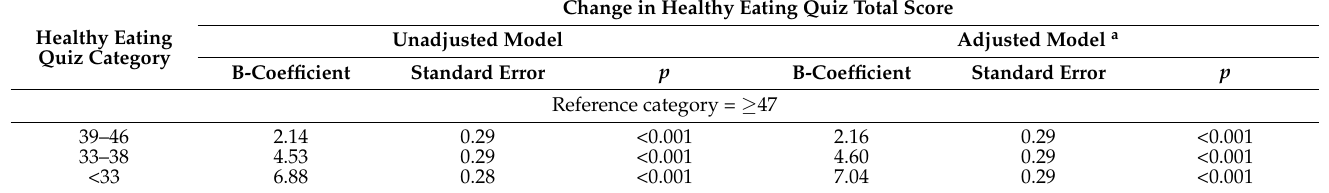
Table 5. Linear regression of change in Healthy Eating Quiz total score for repeat completers by baseline score category ( n =